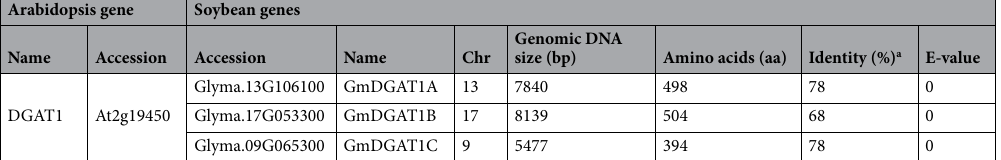
Table 1. Type I Diacylglycerol O-acyltransferase ( DGAT1 ) genes in Arabidopsis and soybean. a The peptide sequence resemblance of soybean candidate genes to the Arabidopsis reference genes.